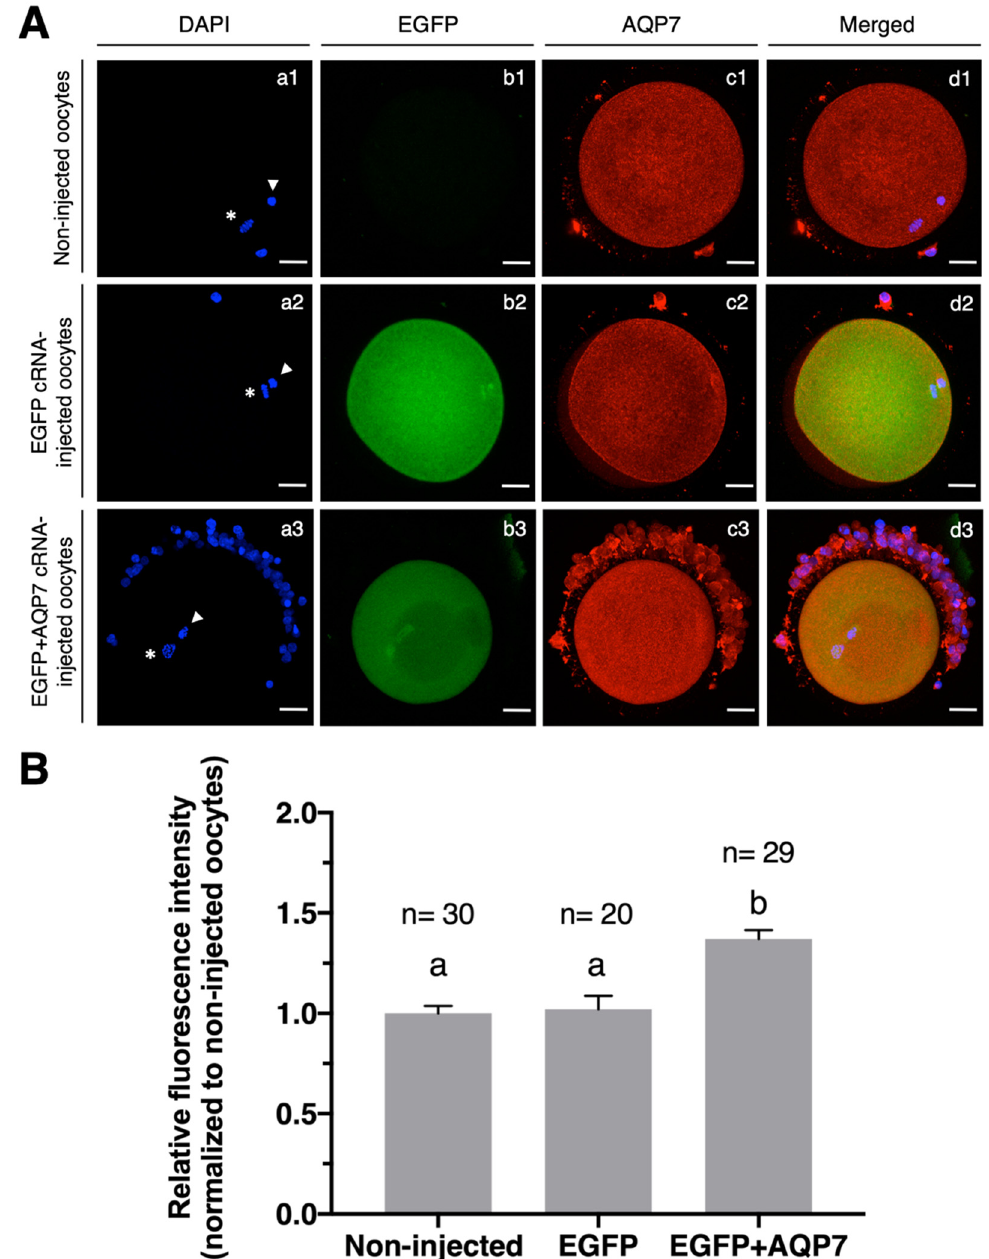
Figure 3. Exogenous expression of EGFP and EGFP+AQP7 cRNA in bovine MII oocytes. ( A ) Immunofluorescence analysis of AQP7 expression in bovine oocytes of non-injected, EGFP cRNA-injected and EGFP+AQP7 cRNA-injected oocytes. Nuclei counterstained with DAPI are displayed in blue (a1–a3), EGFP expression is displayed in green (b1–b3) and AQP7 protein expression is displayed in red (c1–c3). Overlayed images are shown in (d1–d3). White asterisk indicates chromosomes; white arrowhead indicates polar body. Scale bar, 30 µ m. ( B ) Summary data of the relative immunofluorescence intensity normalized to control. Data are presented in arbitrary units ± SEM, n ≥ 20, a,b Different letters indicate statistically significant differences between treatments ( p < 0.05). Co-injection of EGFP cRNA with cRNA encoding AQP7 and further immunostaining for AQP7 demonstrated that 100% of oocytes expressing EGFP also co-expressed AQP7 (Table 2). Immunofluorescence staining of AQP7 showed highly specific expression in the ooplasm and around the oolemma of EGFP+AQP7 cRNA-injected oocytes. Although we were able to determine its expression near the oolemma, we could not clearly confirm